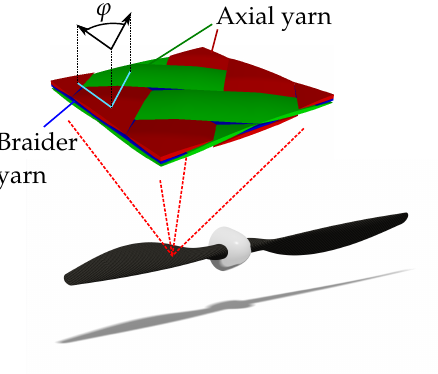
Figure 4. Propeller structure and used meso-model [17].